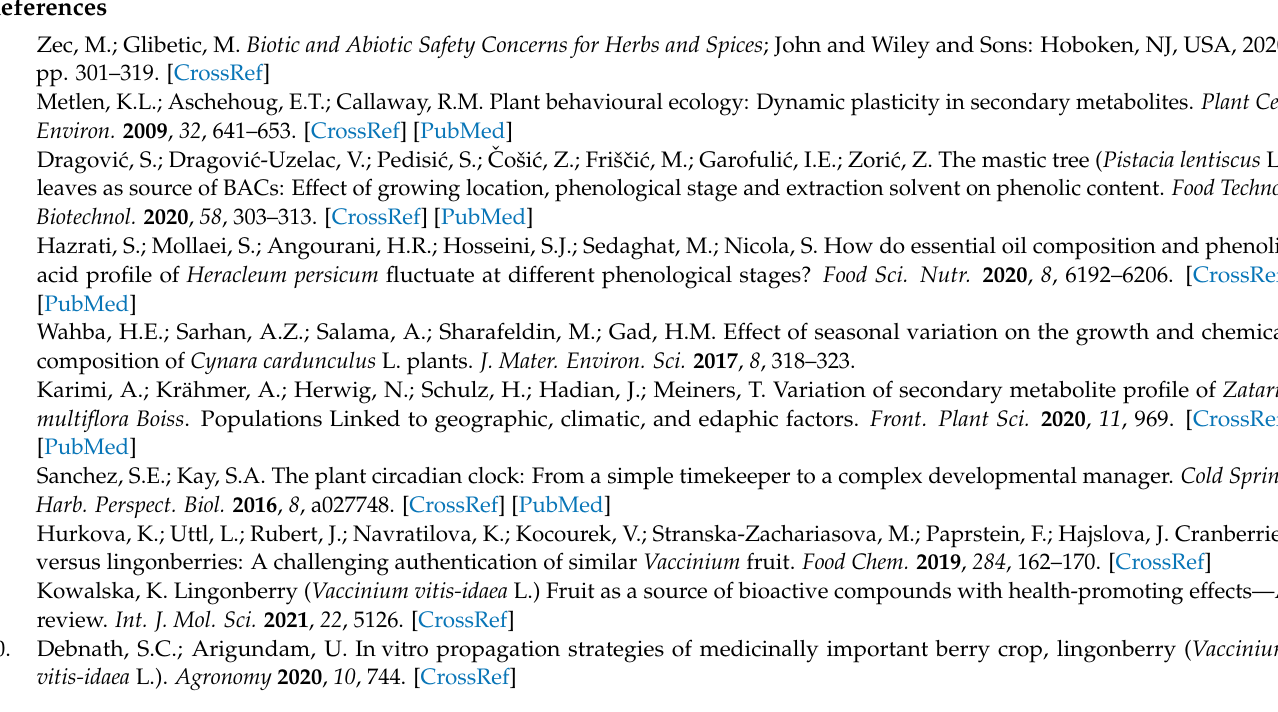
Table S1: Contents of anthocyanins ( µ g/g DW ± SD) in lingonberries, collected at different locations; Table S2: Contents of flavan-3-ols and proanthocyanidins ( µ g/g DW ± SD) in lingonberries, collected at different locations; Table S3: Contents of flavonol glycosides ( µ g/g DW ± SD) in lingonberries, collected at different locations; Table S4: Contents of phenolic acids ( µ g/g DW ± SD) in lingonberries, collected at different locations; Table S5: Contents of simple phenolics, phenolic acids precursors, flavonol aglycones, and stilbenes ( µ g/g DW ± SD) in lingonberries, collected at different locations; Table S6: Contents of triterpenoid acids and sterols ( µ g/g DW ± SD) in lingonberries, collected at different locations; Table S7: Contents of neutral triterpenoids ( µ g/g DW ± SD) in lingonberries, collected at different